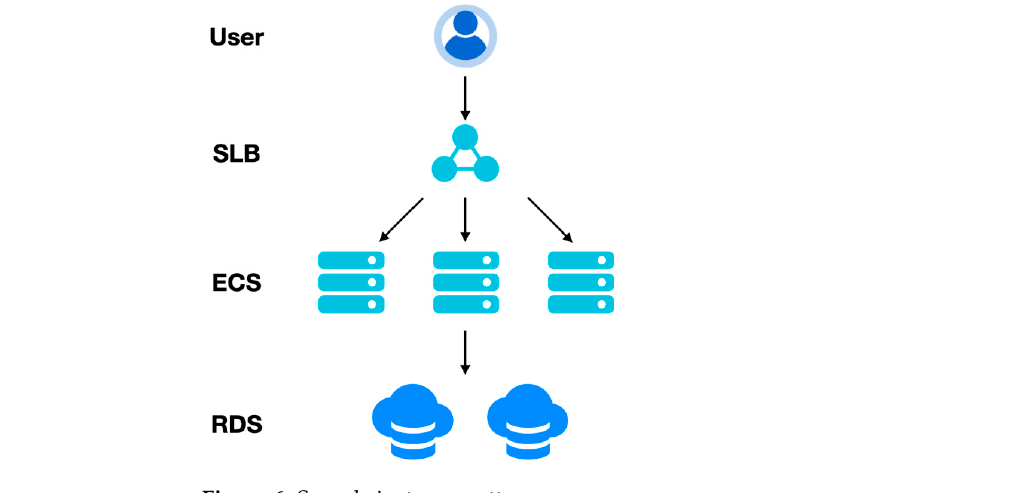
Figure 5. User upload and download interface.